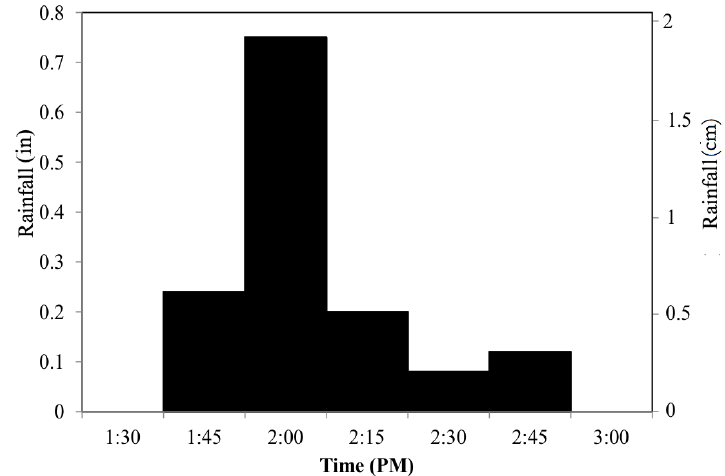
Figure 8. Rainfall Hyetograph for the flood event on 11 September